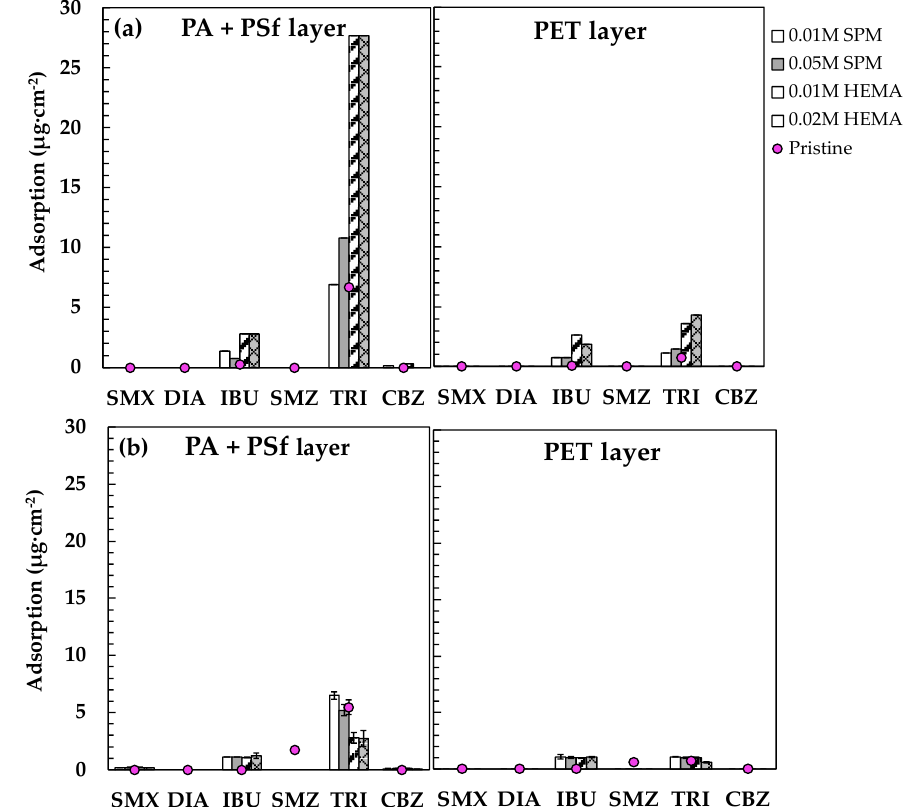
Figure 6. Adsorption of IBU and TRI extracted from PA + PSf and PET layers of the pristine and modified NF90 before ( a ) and after ( b ) silica fouling. Error bars represent one standard deviation of triplicate measurements. SMX: sulfamethoxazole, DIA: sulfadiazine, IBU: ibuprofen, SMZ: sulfamethazine, TRI: triclosan, CBZ: carbamazepine. The data of pristine membrane were summarized from our previous work [19,42].